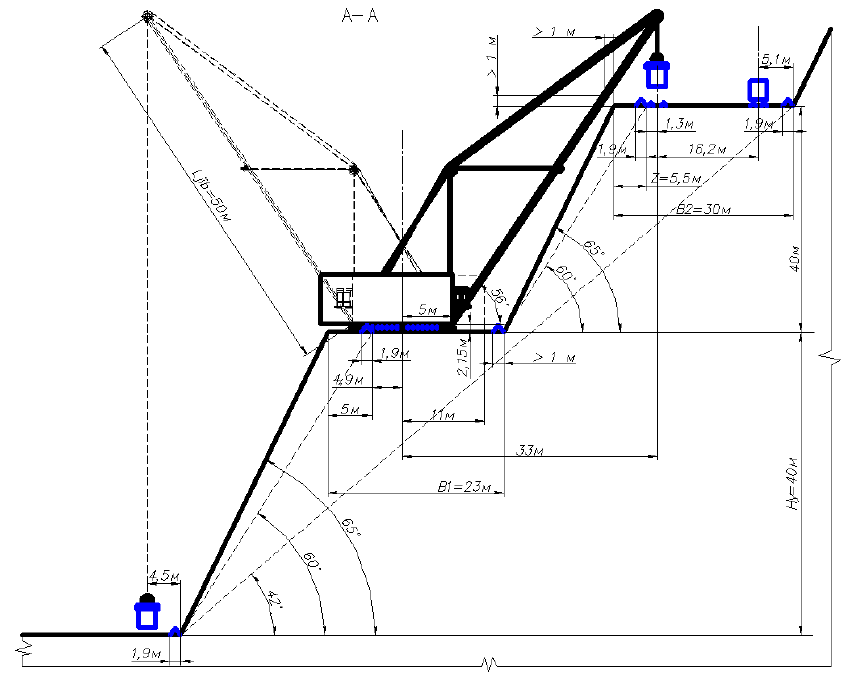
Fig. 4. Passport of setting up a hoist on a